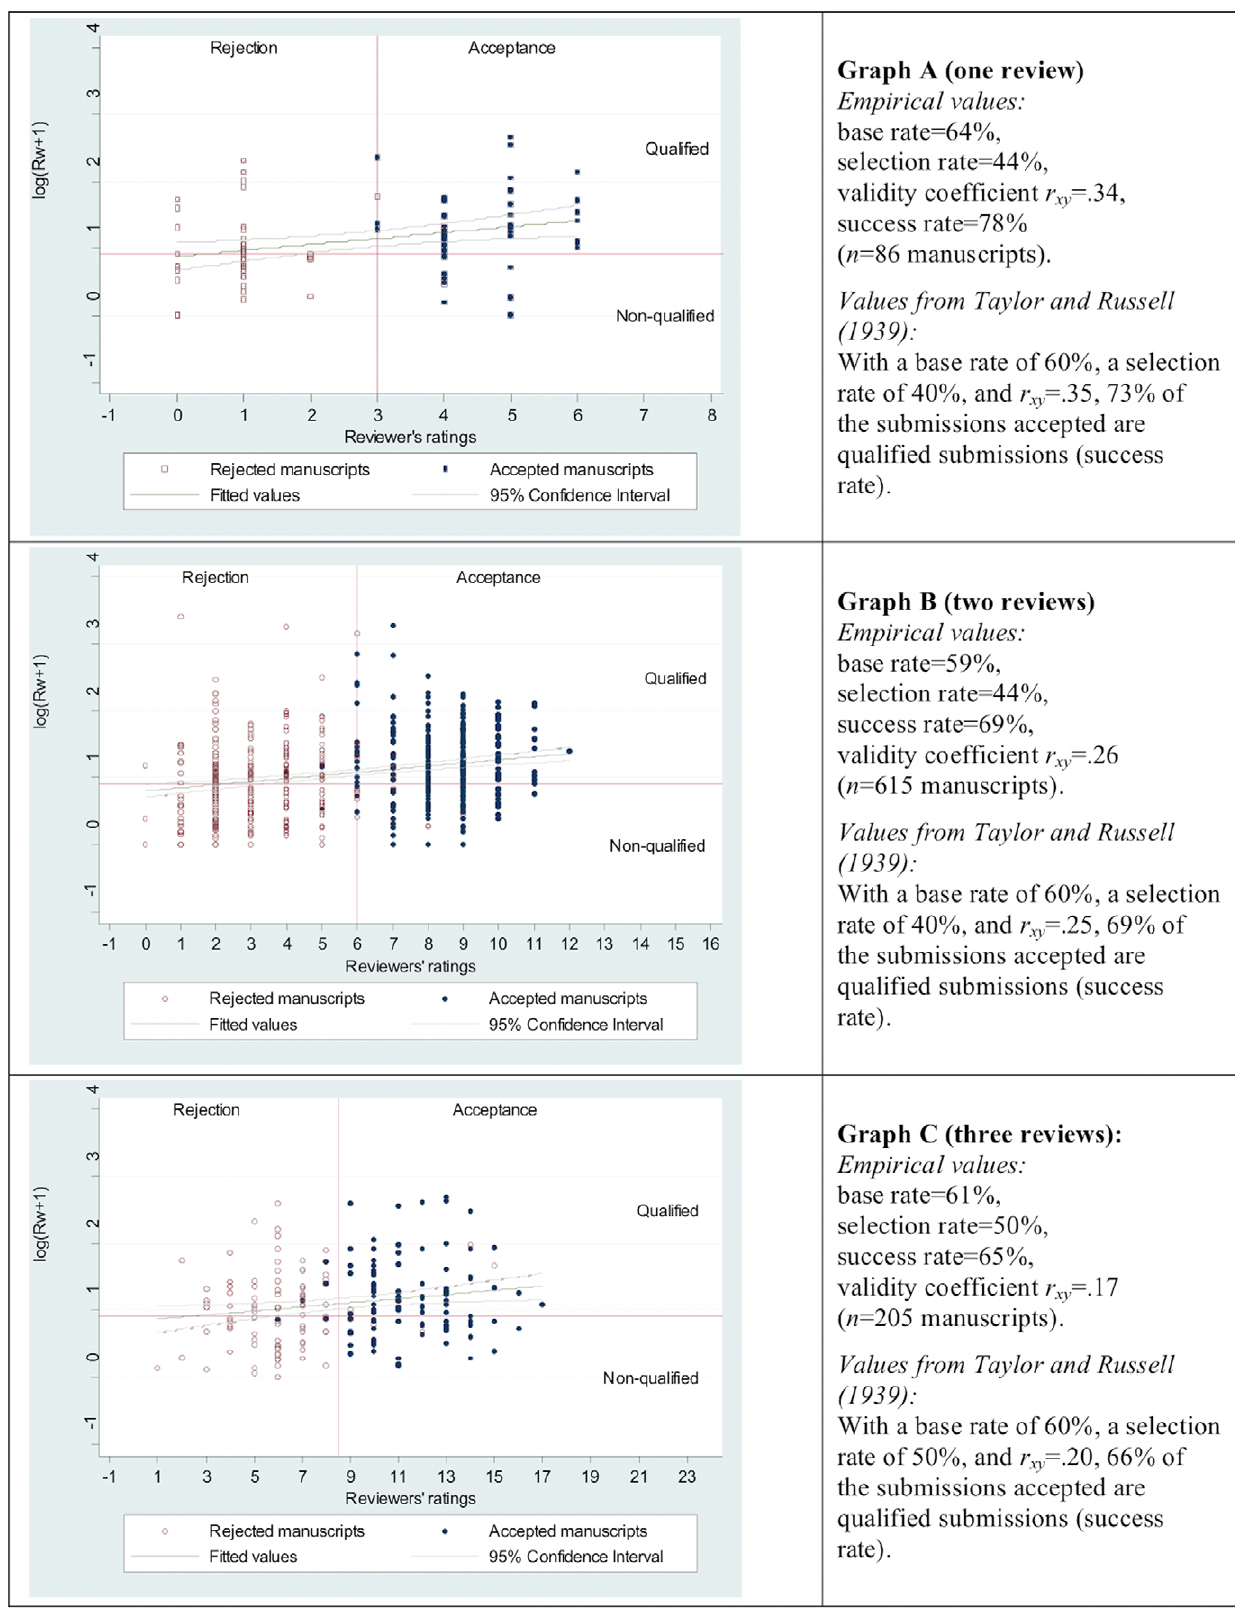
Figure 2. Base rate, selection rate, success rate, and validity coefficient ( r xy ) in the reviewing of AC-IE submissions by one (Graph A), two (Graph B), or three (Graph C) reviewers. The green line in the graphs along with 95% confidence interval (gray lines) is the prediction for the criterion, based on a linear regression of the criterion on the predictor.